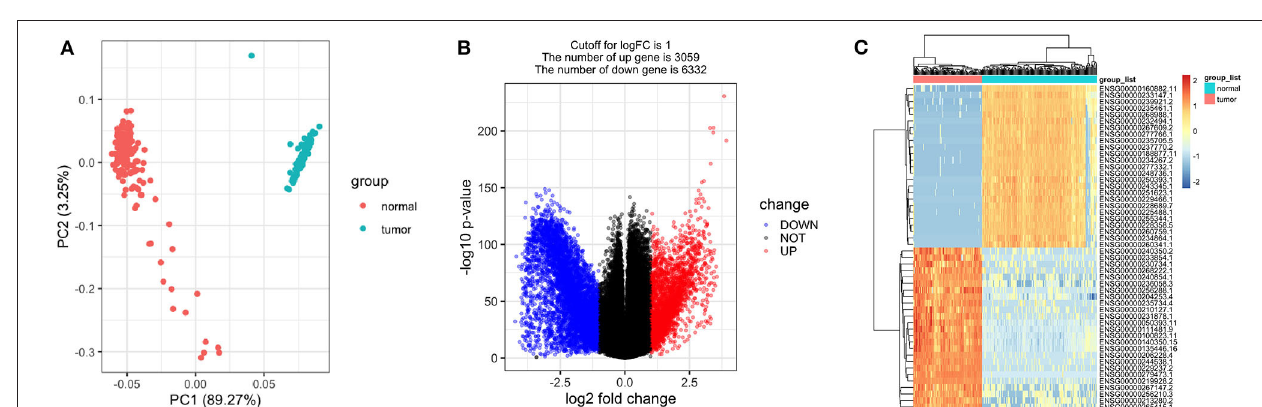
FIGURE 2 | Differentially expressed genes between stage I testicular germ cell tumors (TGCTs) and normal testis tissues. Principal component analysis plot (A) , volcano plot (B) , and heatmap (C) demonstrating differentially expressed genes between stage I TGCT and normal tissues.